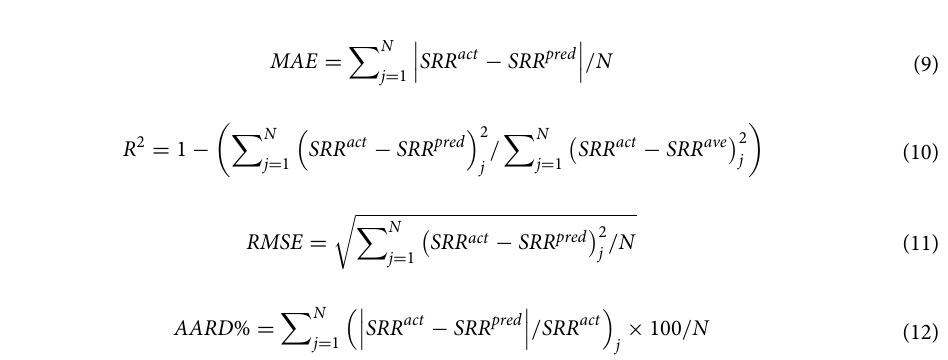
Figure 4. Constructing the WT-ANN model utilizing the trial-and-error technique and genetic algorithm